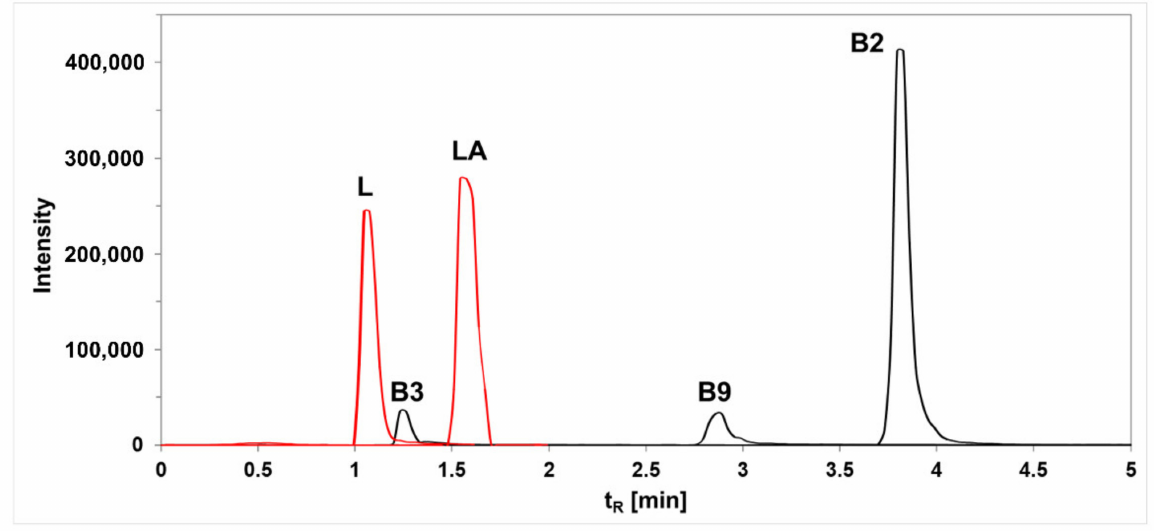
Figure 5. Exemplary chromatograms obtained during the analysis of selected compounds by HPLC. L—lactose; LA—lactic acid; B2—riboflavin; B3—niacin; B9—folic acid; tR—retention